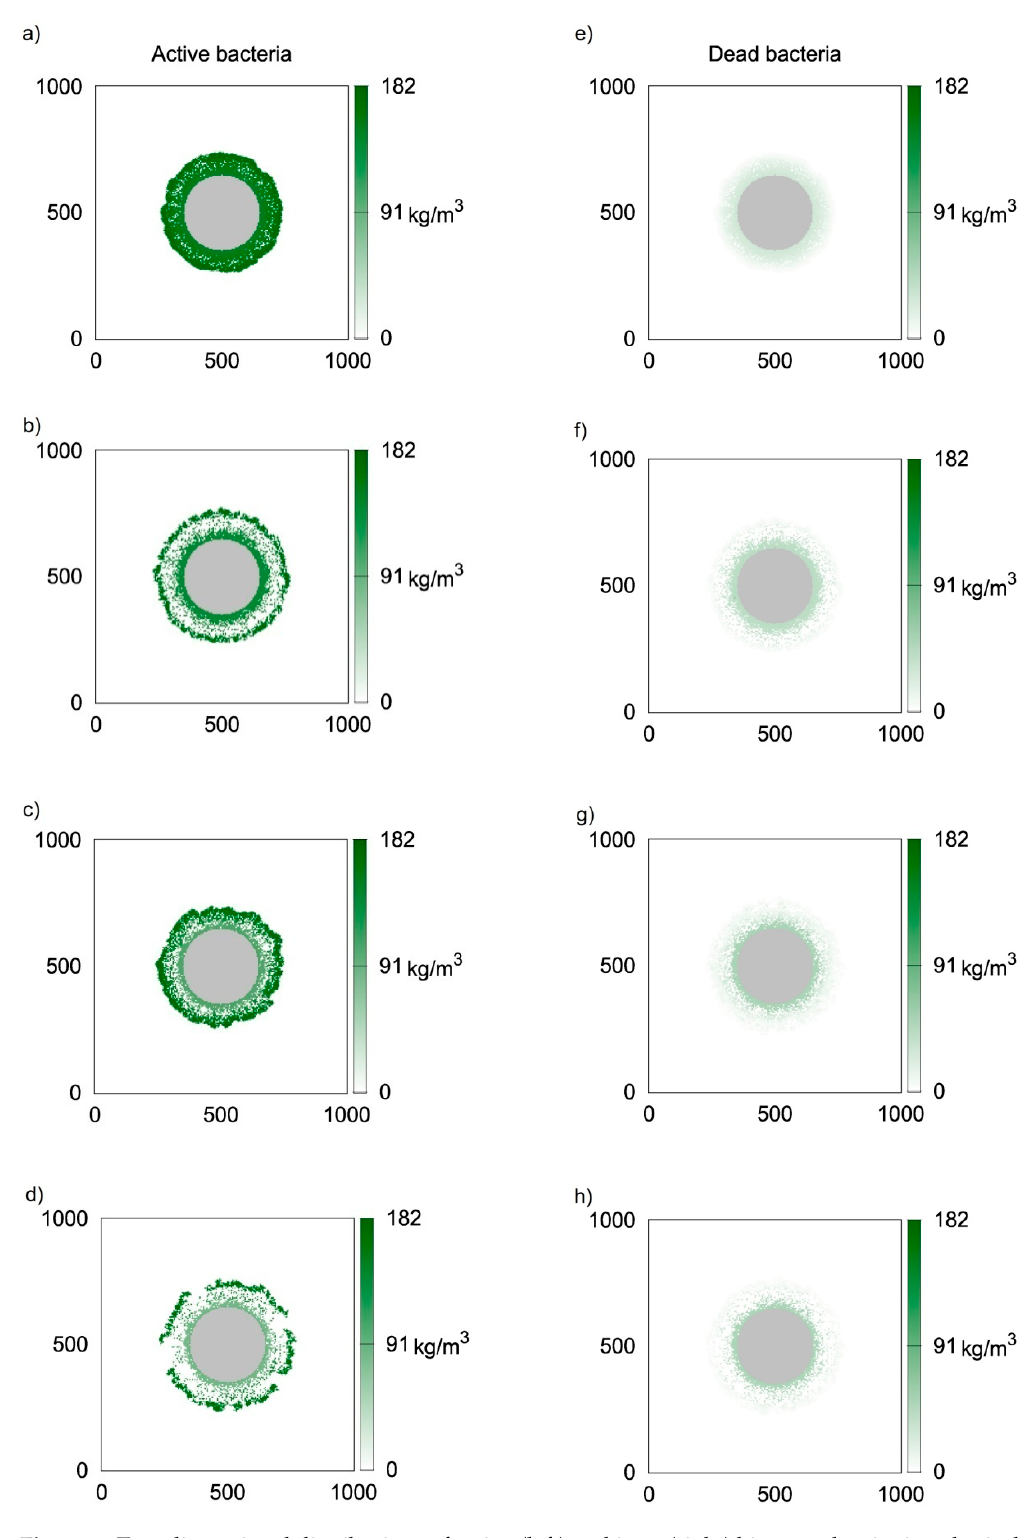
Figure 4. Two-dimensional distributions of active (left) and inert (right) biomass density in spherical biofilm obtained with the use of CA-3 ( k lys = 1.12 h − 1 ); values on vertical and horizontal axes are expressed in µ m; successive rows represent time moments: ( a , e ) t = 50 h; ( b , f ) t = 100 h; ( c , g ) t = 150 h; ( d , h ) t = 200 h.